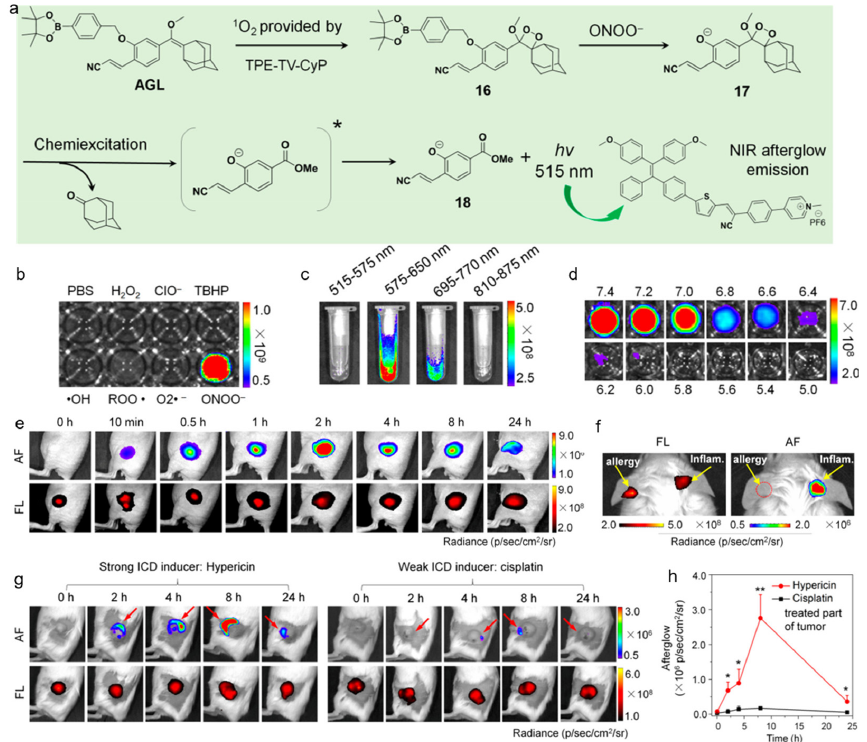
Figure 12. ( a ) Chemical structures and working mechanism of the ONOO − and pH dual-response afterglow luminescence; ( b ) selectivity of the nanoprobe with various ROS treatments; afterglow intensity of the nanoprobe ( c ) in different spectral regions and ( d ) different pH environments; ( e ) fluorescence and afterglow images of the acute inflammation after injecting the preirradiated nano- probe at different time points; ( f ) fluorescence and afterglow images of the mouse with allergic left ear and inflammatory right ear; ( g ) fluorescence and afterglow images of the 4T1 tumor-bearing mice at different time points after receiving PDT with hypericin or cisplatin treatment and ( h ) cor- responding afterglow intensity. * p < 0.05, ** p < 0.01. (Reproduced with the permission from ref. [147]. Copyright 2022, American Chemical Society). 3. Detection of Gasotransmitters Small gaseous molecules including NO, CO, and H 2 S, function as important signal transmitters in living systems as they are associated with many biological functions and major diseases [148–151]. NO is a neutral diatomic free radical that is produced from L - arginine by NO synthase (NOSs) isoforms such as neuronal NOS (nNOS), inducible NOS (iNOS), and endothelial NOS (eNOS) [152,153]. CO is the second gasotransmitter that is generated as a byproduct of haem cleavage by two distinct haem oxygenases [154]. H 2 S is predominantly formed from Cys or its derivatives by the enzymes cystathionine β -syn- thase and cystathionine γ -lyase [155]. All these gasotransmitters play vital roles in vaso- relaxation and inflammatory responses, thus, numerous molecular probes have been de- veloped for precise monitoring of related diseases [156–158]. For example, the o -diamino aromatic moiety is a recognition group for NO, and the cyclization reaction of o -diamine with NO produces a triazole moiety, which alters the electronic property and conjugation nature [159–161]. For H 2 S detection, the popularly used approaches include reduction of